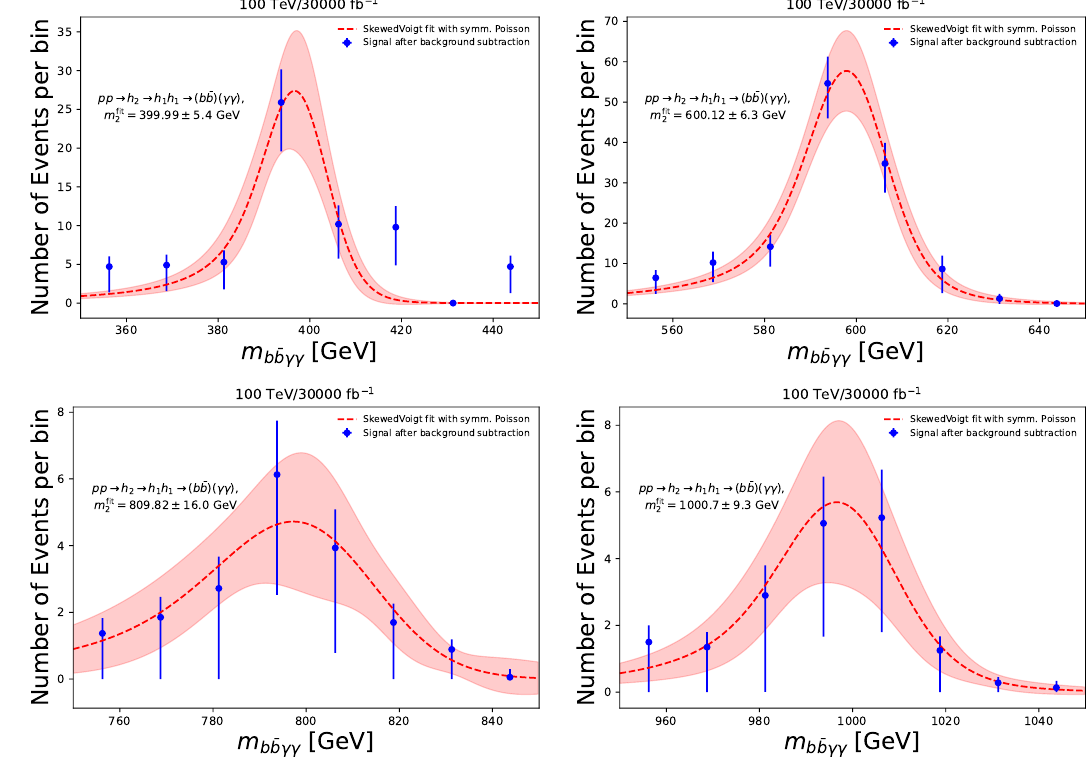
Figure 2 . A selection of results obtained through the mass fitting procedure outlined in the main text is shown. We show the fits for cross sections corresponding to significances of Σ ’ 20 in the pp → h ( b ¯ b )( γγ ) channel at a 100 TeV collider with an integrated luminosity of 2 → h 1 h 1 → 30 ab − 1 , for real masses m = 400 , 600 , 800 , 1000 GeV corresponding to top left, top right, lower 2 left and lower right. The blue error bars represent the expected number of signal events in each bin and the red dashed curve and red error band represent the fit and its corresponding uncertainty as obtained by the lmfit